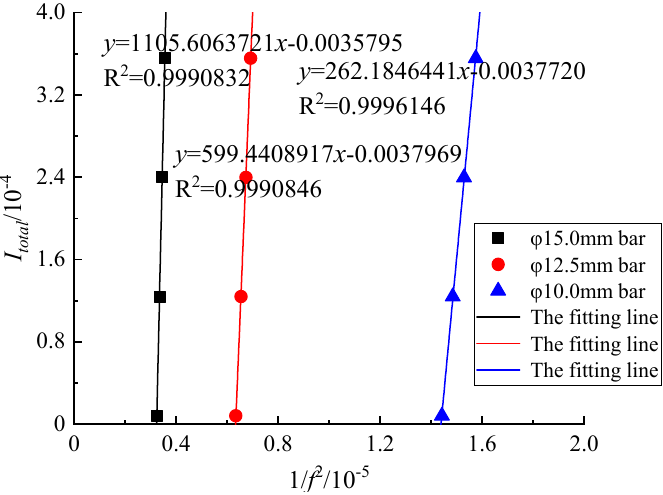
Figure 5. Calibration result of the unsaturated BE-RC test system.